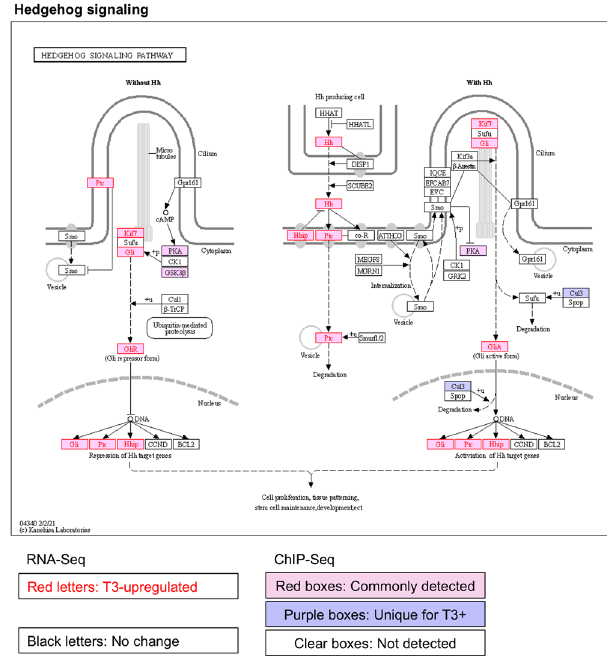
Fig. 3 TR-binding and regulation of genes in the hedgehog signaling pathway in intestine based on ChIP-Seq and RNA-Seq data. The hedgehog signaling pathway was visualized with regard to genes regulated by T3 based on RNA-Seq and/or bound by TR based on ChIP-Seq. The arrows show functional interaction: green for activation; red for inhibition. Letters in red indicate upregulated genes in wild-type intestine after T3 treatment. Letters in black indicate genes with no change in wild-type intestine after T3 treatment. Red boxes indicate ChIP-Seq detected genes both with and without T3 treatment, and purple boxes indicate genes identi fi ed by ChIP-Seq only in wild type with T3 treatment. Note that many genes including Sonic hedgehog (Hh) were upregulated by T3 and also bound by TR. No downregulated genes were found by RNA-Seq in this